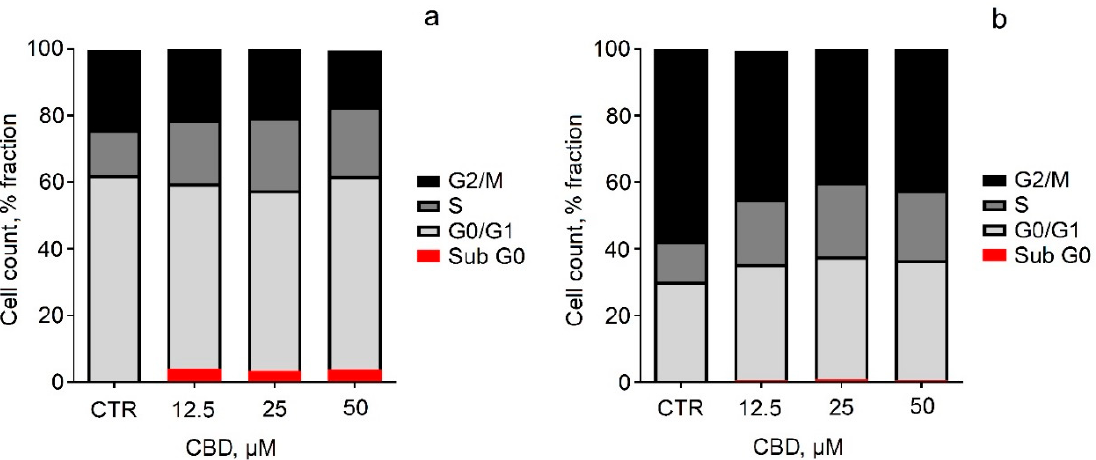
Figure 5. Cytotoxic effects after treatment of SH-SY5Y cells ( a ) and Neuro-2a cells ( b ) with pure CBD. Values are presented as the percentage of untreated controls and expressed as mean ± SD ( n = 6).